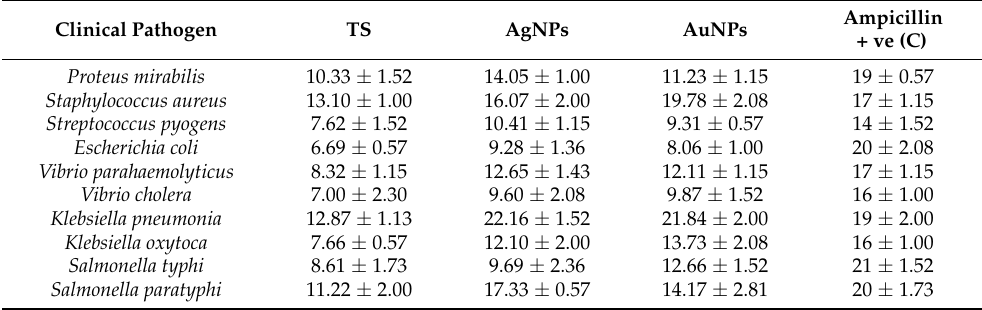
Table 6. Antibacterial activity (as indicated by inhibition zones) of nanoparticles and extracts of Thraustochytrium kinnei against clinical